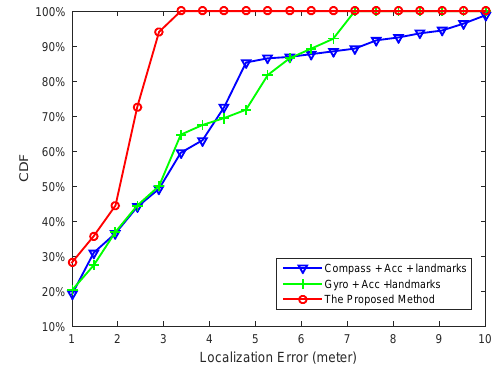
Figure 8: Performance comparison of different